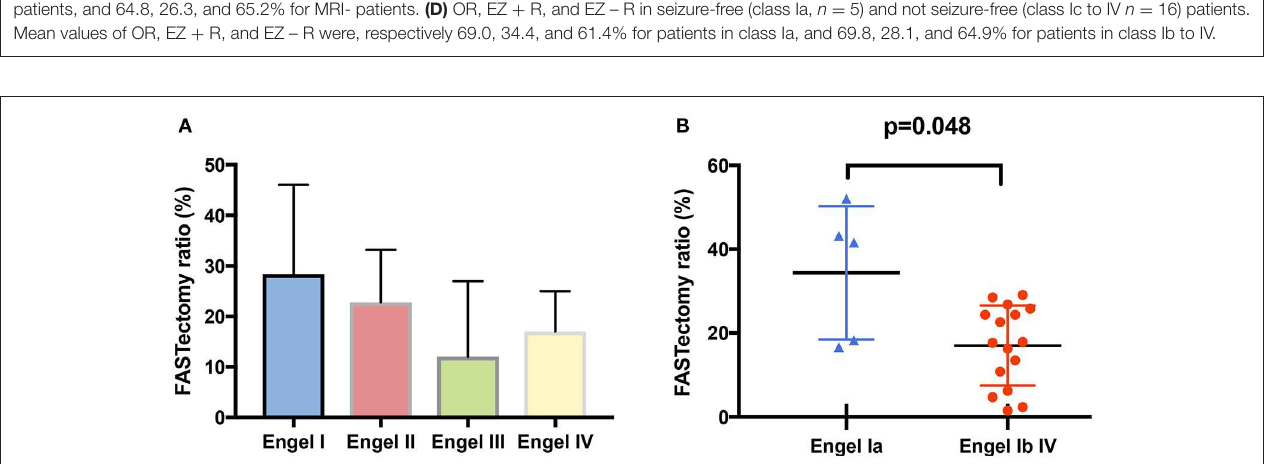
FIGURE 4 | FASTectomy ratios depending on post-operative outcome. (A) FASTectomy ratio was globally higher in class I patients (mean: 28.4%), as compared with class II (mean: 22.8%), class III (mean: 12.1%), and class IV (men: 17%) patients. (B) The mean FASTectomy ratio was higher in completely seizure-free patients (class Ia) than in non seizure-free patients (class Ib to IV) and the difference was statistically significant ( p = 0.048, Mann-Whitney test). Nine non seizure-free patients, however, had a higher FASTectomy ratio than some of class Ia